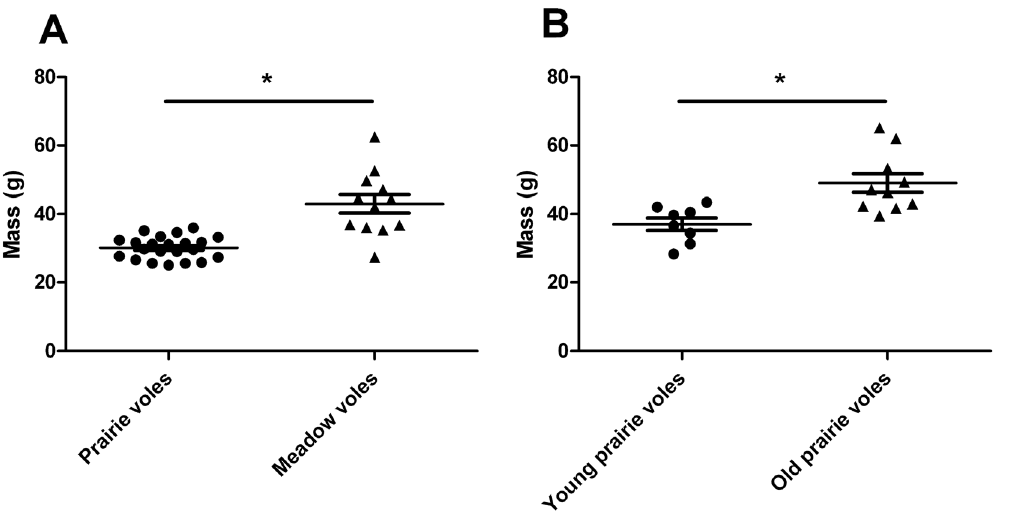
Figure 6. Body mass. Meadow voles had significantly greater body mass than prairie voles in Experiment 1 (A). In Experiment 2, older prairie voles age-matched to meadow voles from Experiment 1 had significantly greater body mass than younger prairie voles (B). Points indicate individual body mass; horizontal lines indicate mean 6 SEM. * effect of group; p , 0.005